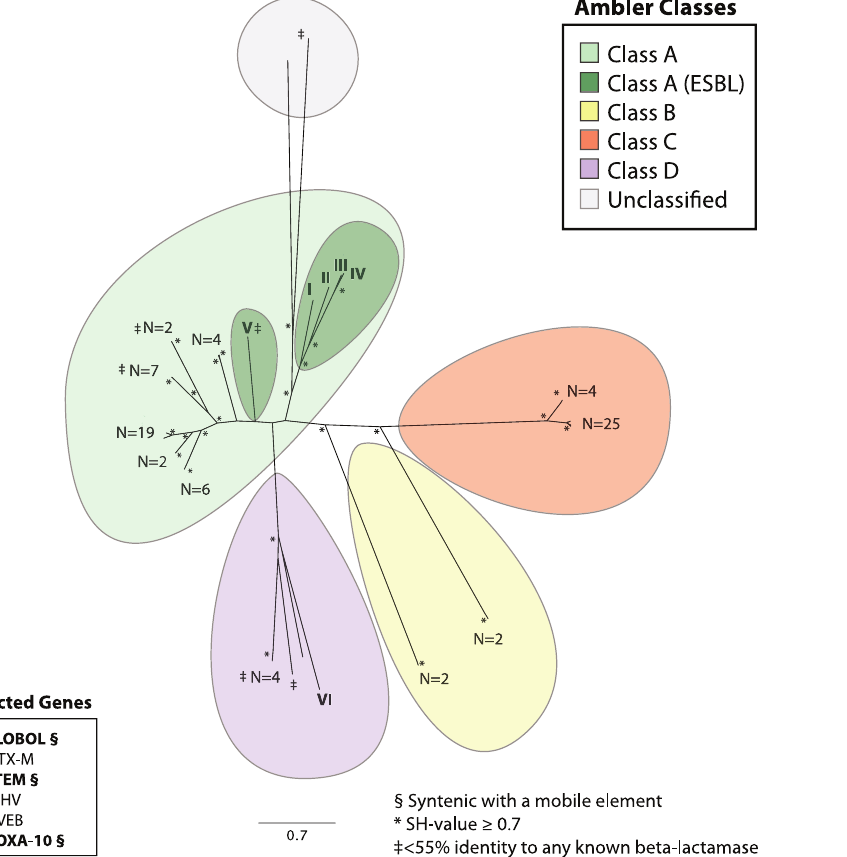
Figure 2. Unrooted approximate maximum-likelihood phylogenetic tree constructed using the predicted amino acid sequences of all beta-lactamases in the study set. Ambler classes are color-coded as indicated in the legend (upper right). At the terminus of each branch, the number of unique amino acid sequences in the terminal cluster is indicated. Branches with identity to extended-spectrum beta-lactamases (ESBLs) are numbered I–V and their putative ESBL classification is listed in the lower left legend of selected genes. A Class D beta-lactamase with high identity to a known OXA-10 is also numbered (VI) and included in the lower left legend. Genes included in the lower left legend that were syntenic with mobile genetic elements are bolded and marked with a 1 . Clusters of sequences with , 55% ID to any known beta-lactamase are marked with a ` . Nodes with a Shimodaira-Hasegawa (SH) value . =0.7 are starred. The Shimodaira-Hasegawa score provides a measure of confidence in tree topology, with a maximum score (highest confidence) of 1.0